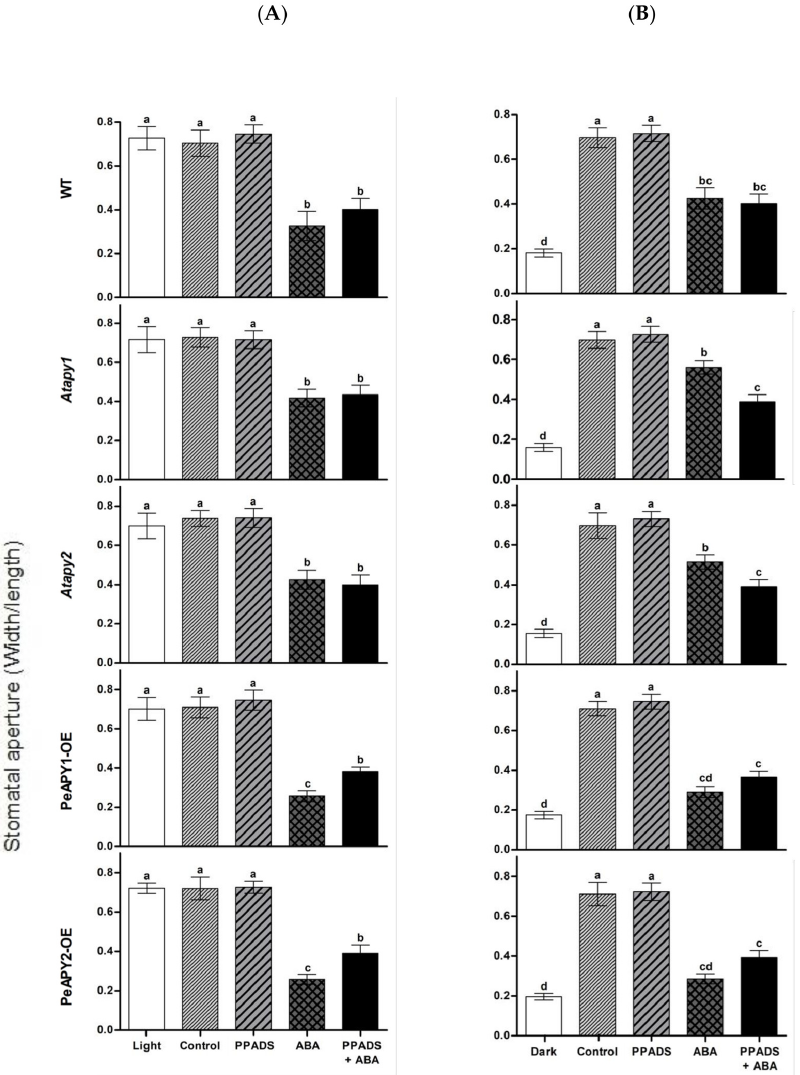
Figure 6. Effects of purinergic receptor antagonist, PPADS, on ABA-regulated stomatal aperture in wild-type (WT), Arabidopsis loss-of-function mutants for APY1 and APY2 ( Atapy1 and Atapy2 ) and transgenic lines of PeAPY1 and PeAPY2 (PeAPY1-OE and PeAPY2-OE). Leaves from three-week- old seedlings were incubated in MES-Tris buffer containing 50 mM KCl and 10 mM MES-Tris (pH 6.15) for 2 h in light (150 µ mol m − 2 s − 1 ) ( A ) or in darkness ( B ). Thereafter, leaves were exposed to 100 µ M PPADS for 2 h in cool light (150 µ mol m − 2 s − 1 ) in the presence and absence of ABA (10 µ M). Controls were treated without the addition of inhibitor or ABA. Stomatal aperture was measured in continuously illuminated leaves ( A ) and dark-adapted plants transferred to light ( B ), respectively. Each column is the mean of three independent experiments, and error bars represent SE. Columns labeled with different letters, a, b, c and d, showed a significant difference at p < 0.05 between treatments and genotypes under conditions of continuous light ( A ) or dark-adapted leaves transferred to light ( B